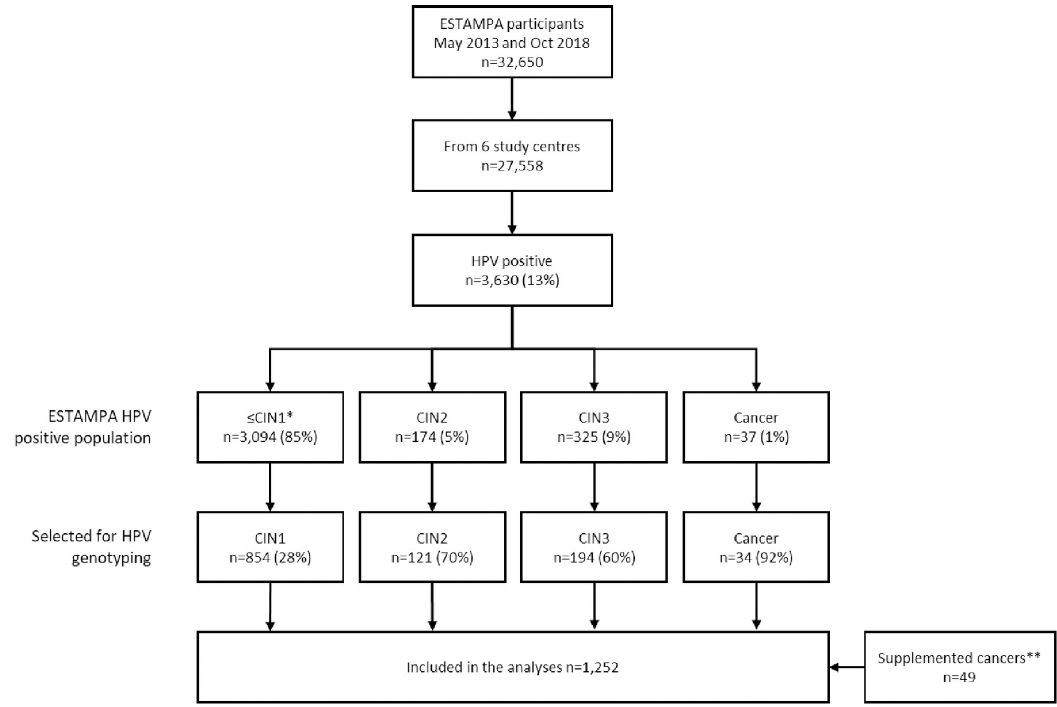
Fig 1. Study population. � Includes colposcopy negative, biopsy negative or CIN1 �� Cancers supplemented from oncologic clinics of 2 countries hosting ESTAMPA. https://doi.org/10.1371/journal.pone.0272205.g001 PLOS ONE | https://doi.org/10.1371/journal.pone.0272205 July 29,